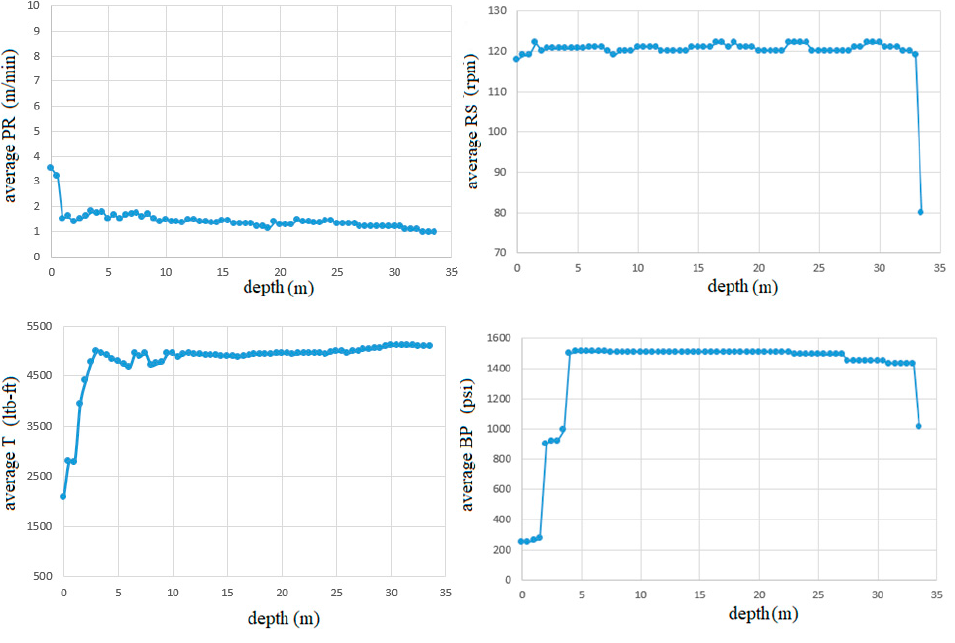
Figure 5. Average signals with depth for MWD data.